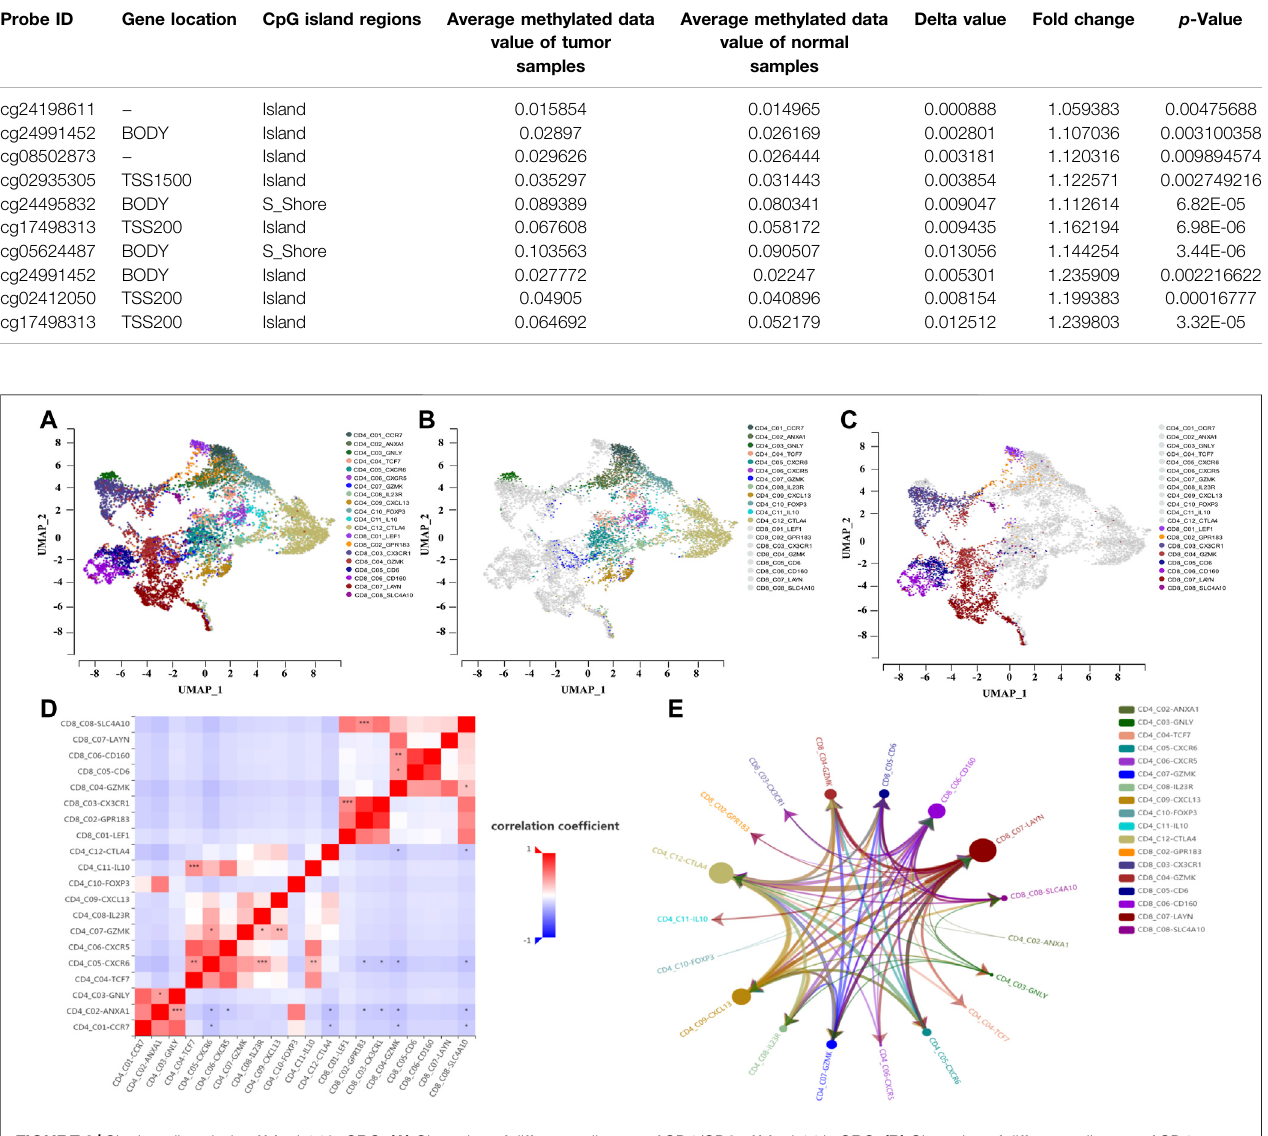
FIGURE6 | Single-cellanalysisofMapk14in CRC. (A) Clusteringof different celltypes ofCD4/CD8 ofMapk14 inCRC. (B) Clusteringof different celltypes ofCD4 of Mapk14 in CRC. (C) Clustering of different CD8 cell types of Mapk14 in CRC. (D) Correlation of the ratio of different cell types of CD4/CD8 of Mapk14 in CRC. (E) Regulatory network between different CD4/CD8 immune cell types of Mapk14 in CRC.